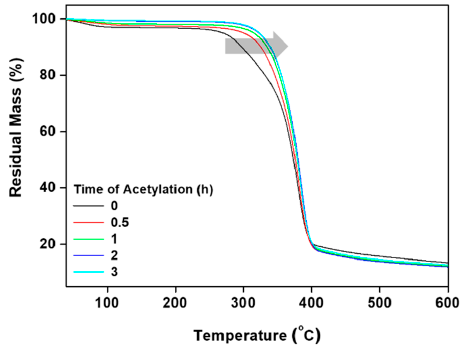
Figure 6. Thermogravimetric curves of kenaf fibers at different acetylation reaction times. Table 1. Temperature by main pyrol.